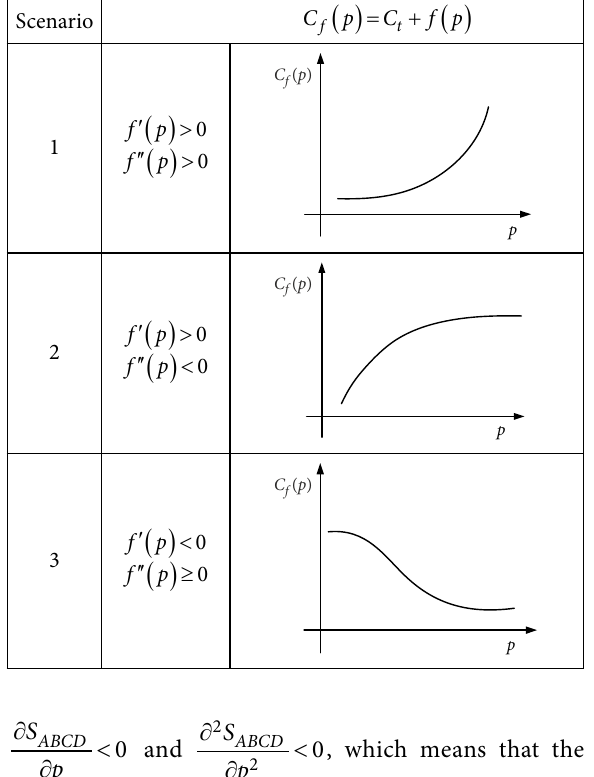
Table 6. The relationships between the cost and PR in different scenarios